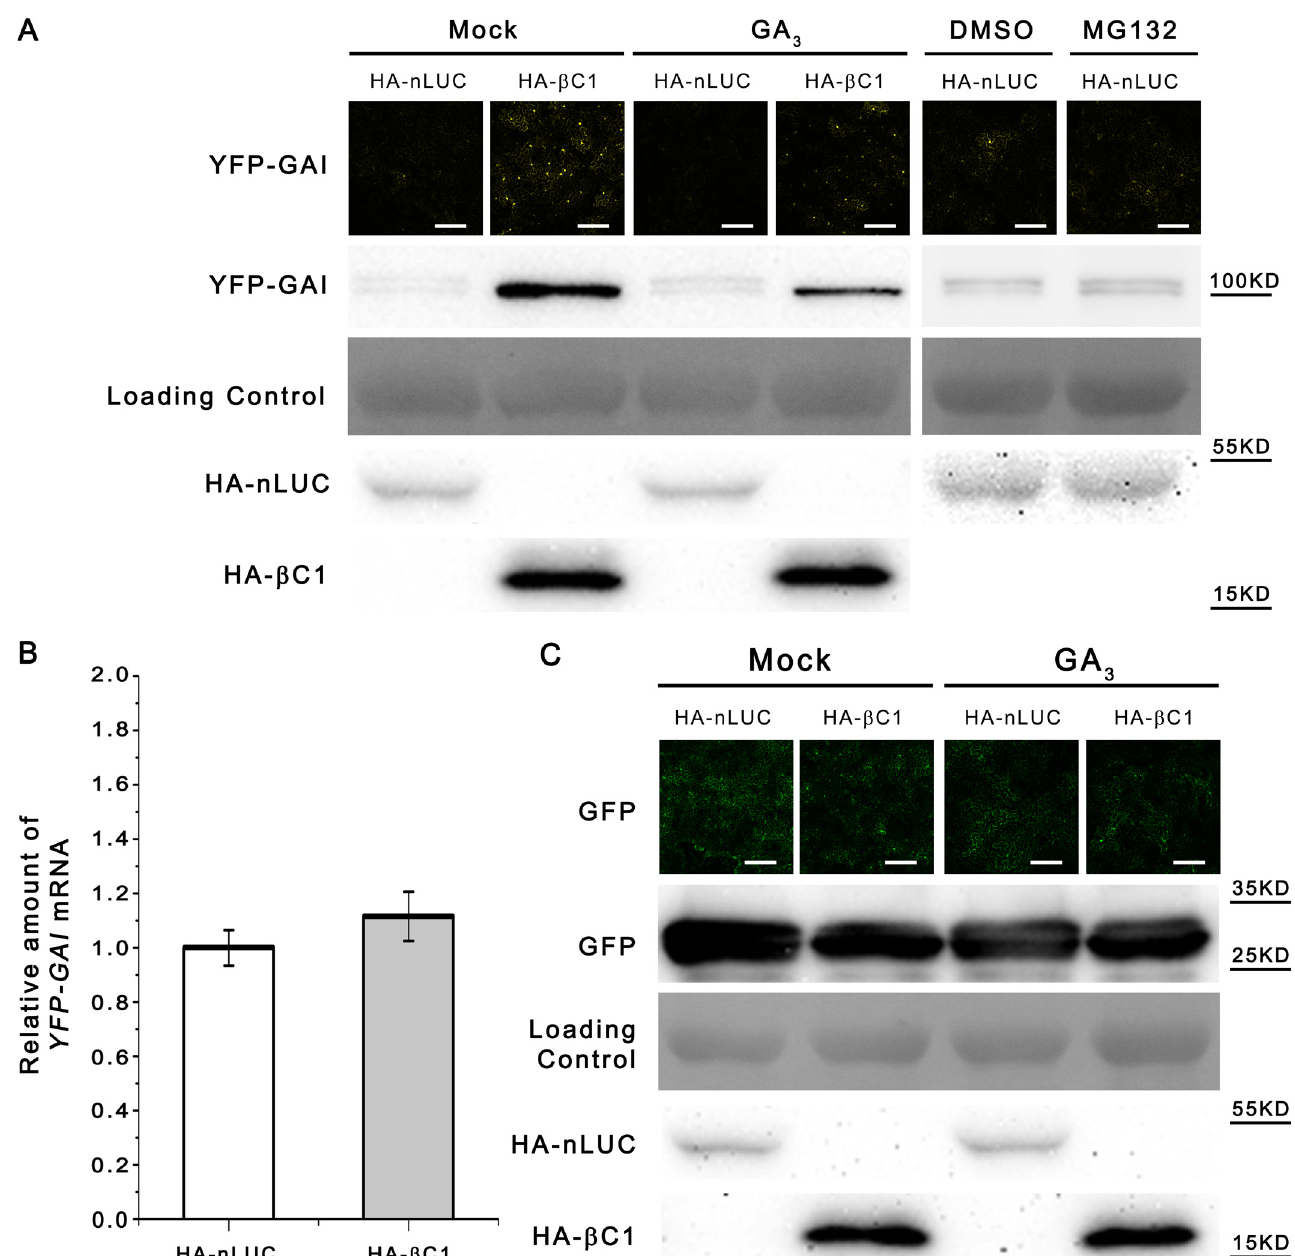
Fig 7. CLCuMuB β C1 hinders the degradation of YFP-GAI in vivo . (A) CLCuMuB β C1 attenued degradation of YFP-GAI in vivo . YFP-GAI expression construct was coinfiltrated with constructs expressing HA-nLUC or HA- β C1 into seven to eight-week-old N . benthamiana plant leaves. Around 48 hpi, agroinfiltrated leaves were sprayed with 100 μ M GA 3 or mock solution (ethonal) and visualized via a Zeiss LSM 710 laser scanning microscope. Bar scales represents 200 μ m. DMSO and MG132 (50 μ M) were applied into plant leaves 12 h before observation. Protein level was analyzed via SDS-PAGE and western blot analysis with the anti-GFP antibody, which also recognizes YFP. The PVDF membrane was stained with Ponceaux to visualize the large subunit of ribulose-1,5-bisphosphate as a loading control. (B) Real-time RT-PCR detected the mRNA level of YFP-GAI. Total RNA was extracted from each N . benthamiana leaves and then subjected to quantitative RT-PCR (means ± SEM, n = 3) to quantify YFP-GAI mRNA level. eIF4a was used as the internal reference. (C) CLCuMuB β C1 didn ’ t affect stability of GFP in vivo . Detection of GFP (as an internal control) in N . benthamiana leaves coinfiltrated with the construct expressing GFP together with constructs expressing HA-nLUC or HA- β C1 and treated with 100 μ M GA 3 or mock (ethanol) solution and visualized via a Zeiss LSM 710 laser scanning microscope. Bar scale represents 200 μ m. Protein level was analyzed via SDS-PAGE and immunoblot analysis with anti-GFP. The PVDF membrane was stained with Ponceaux to visualize the large subunit of ribulose-1,5-bisphosphate as a loading control.